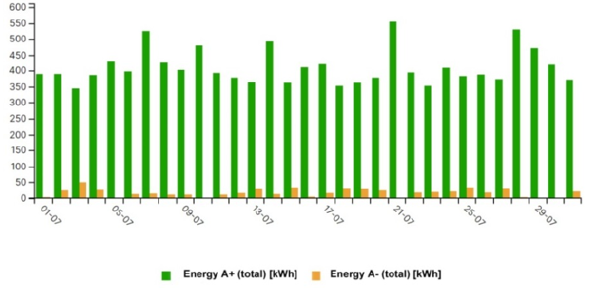
Figure 2: Graph of energy consumed (A+) and donated (A − ) in Sector 4 LSTP in the month of July 2019